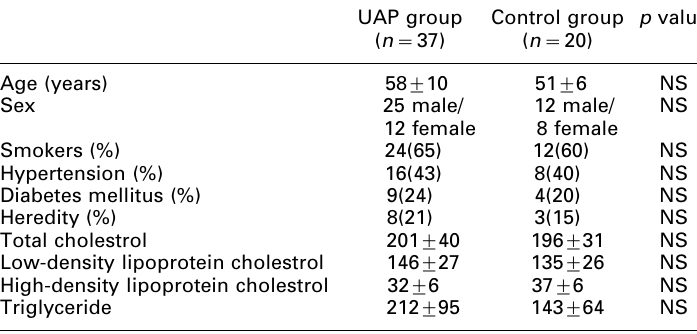
Table 1. Characteristics of